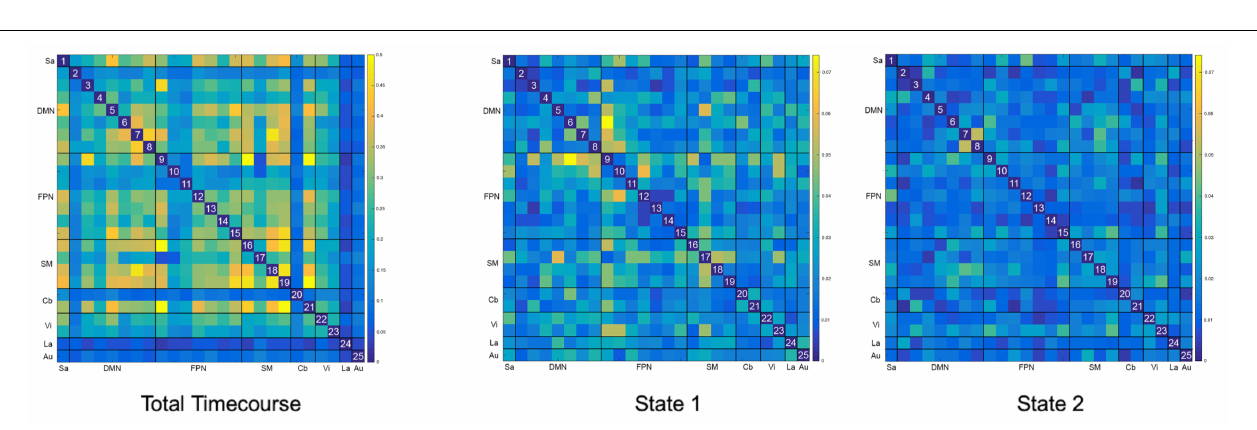
FIGURE 3 | Static and Dynamic Functional Connectivity Matrices. The overall static resting state functional connectivity (Total Timecourse) of the whole brain shows a strongly interconnected network, which is also seen as a relatively hyperconnected state (State 1) in dynamic functional connectivity. A relatively hypoconnected state (State 2), which is actually the predominant brain state for most subjects was only revealed with dynamic functional connectivity analysis.